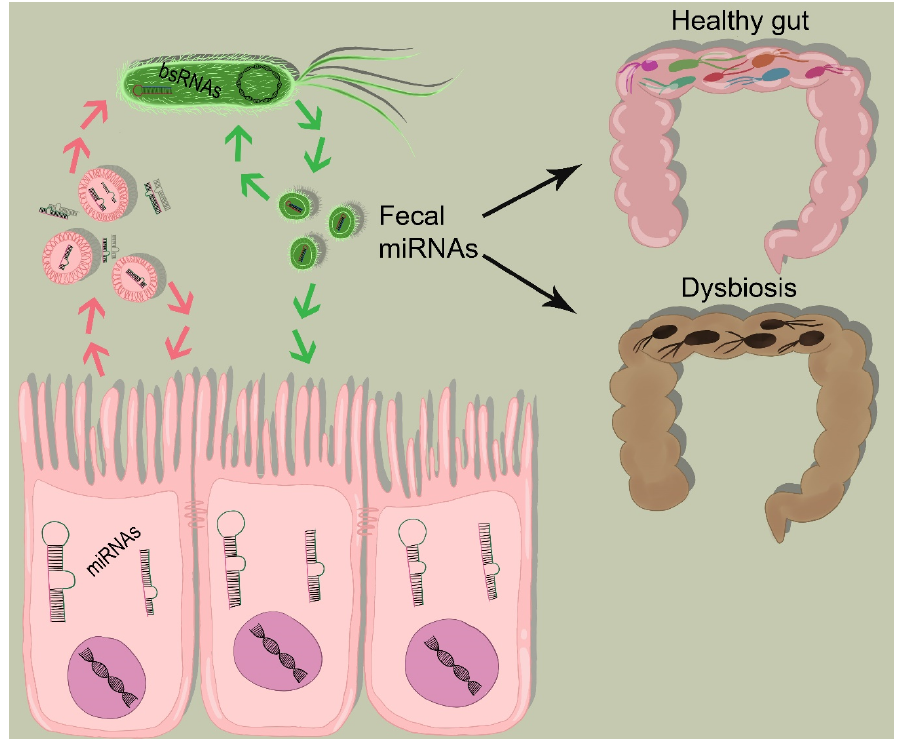
Figure 2. Molecules as messenger in bacteria-host communication. Fecal miRNAs from eukaryotic cells and bsRNAs from bacteria can be taken up by bacteria or by host cells, respectively, and critically mediate bacterial–host communication. Host-derived miRNAs can regulate bacterial gene transcripts and affect bacterial growth which might promote intestinal dysbiosis.